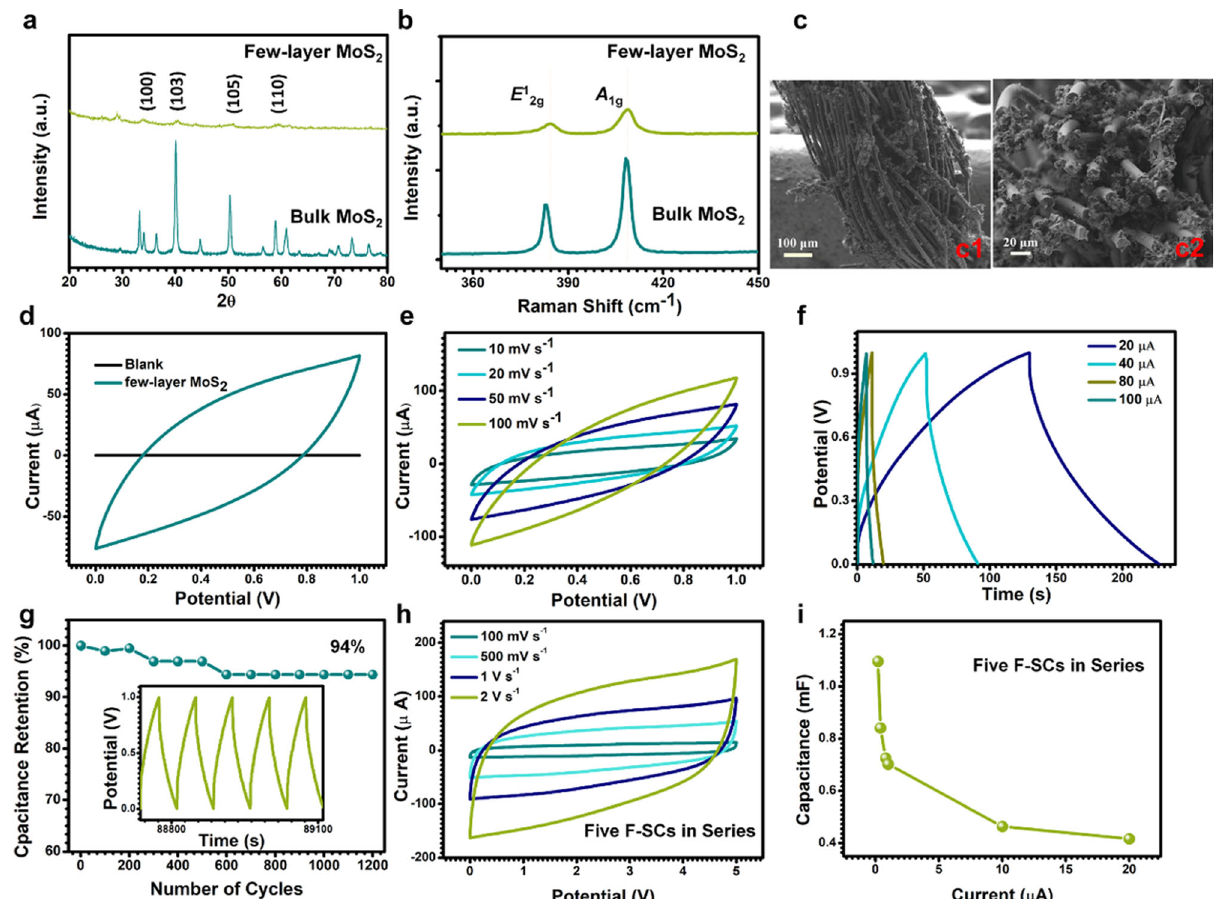
Fig. 5 The performance of fi ber-supercapacitors (F-SCs). a X-ray diffractometry and b Raman patterns of a few-layered MoS 2 and bulk MoS 2 , respectively. c Scanning electron microscopy images of the few-layered MoS 2 dipped carbon fi ber ( c1 is top view and c2 is cross view). d Cyclic voltammetry (CV) curves at a scan rate of 50 mV s − 1 of F-SC with and without few-layered MoS 2 . e CV curves of the F-SC at the different scan rates. f Galvanostatic charge-discharge (GCD) curves of one F-SC at different current. g Cycle stability for 1200 cycles for F-SC (the insert is the detail of GCD curves after long time charge-discharge). h CV curves of the 5 F-SCs connected in series at the different scan rates. i The summary plot of capacitances of 5 F-SCs connected in series versus different discharging